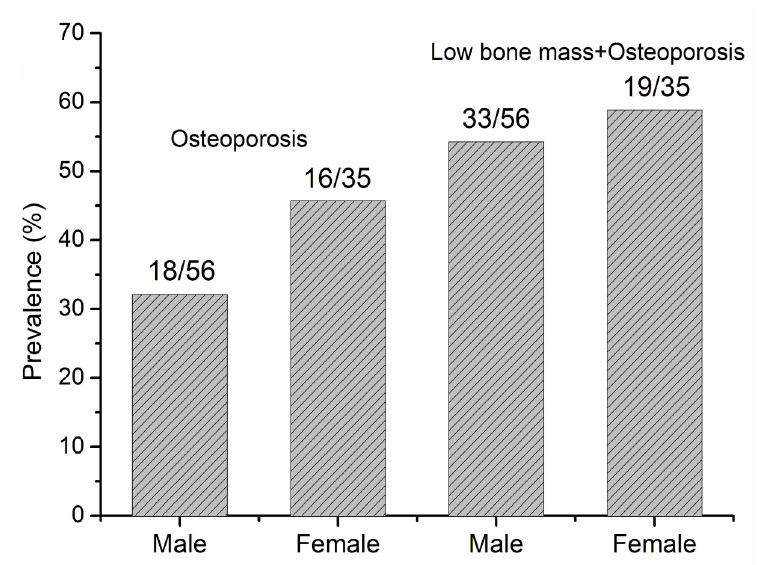
Figure 2. The prevalence of osteoporosis and bone loss (low bone mass + osteoporosis) in patients with pancreatic neuroendocrine tumors (PNETs).